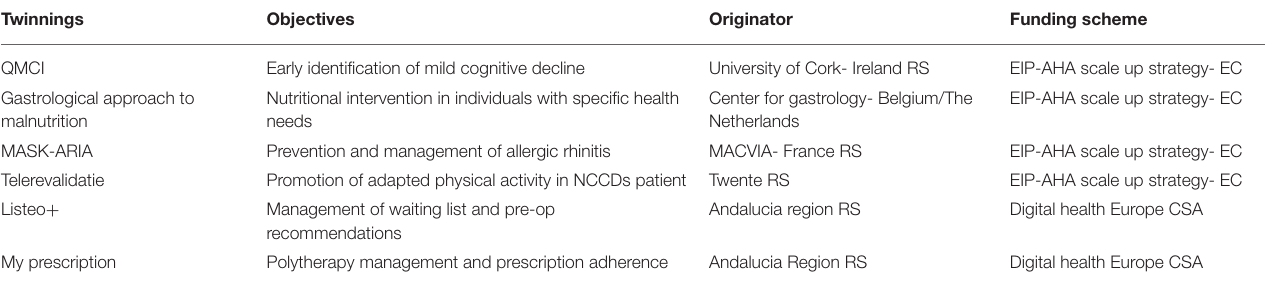
TABLE 2 | The good practices exploited by Campania regional health system (RHS) through twinning activities.